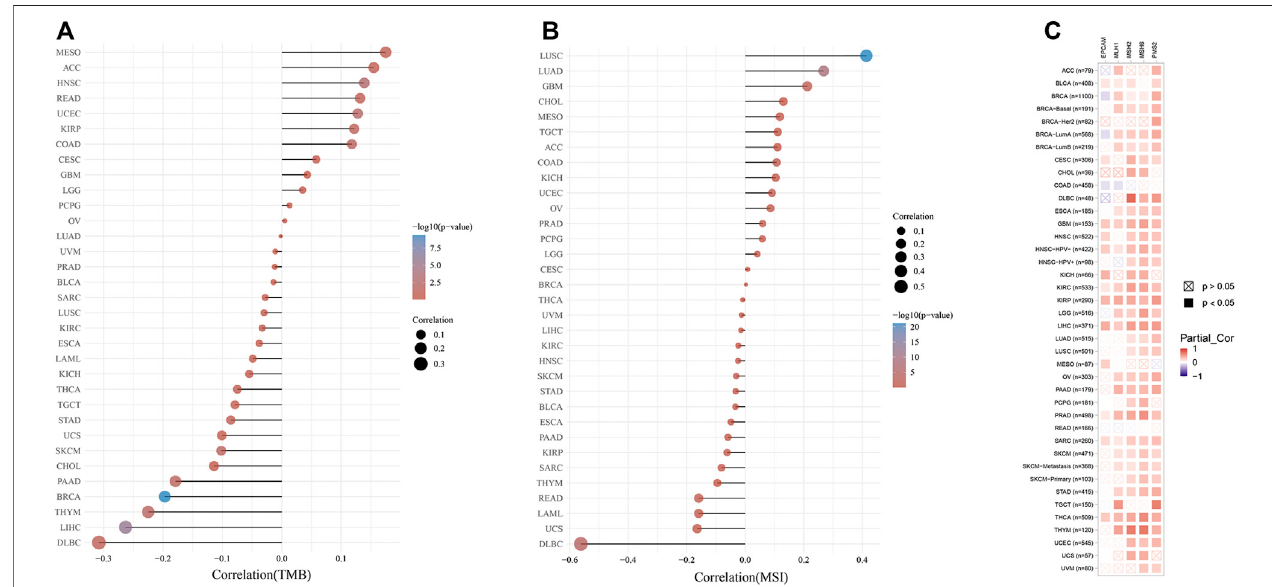
FIGURE 6 | Correlations between the KDM6B expression and tumor mutational burden (TMB), microsatellite instability (MSI), and mismatch repair (MMR). (A) Spearman correlation analysis of KDM6B and TMB. (B) Spearman correlation analysis of KDM6B and MSI. The abscissa represents the correlation coef fi cient between genes and TMB or MSI; the ordinate represents different tumors. The size of the dots represents the size of the correlation coef fi cient, and the colors represent the signi fi canceofthe p value.Thebluerthecolor,thesmalleristhe p value. (C) CorrelationsbetweenKDM6BlevelsandMMRgene( MLH1,MSH2,MSH6,PMS2, and EPCAM )